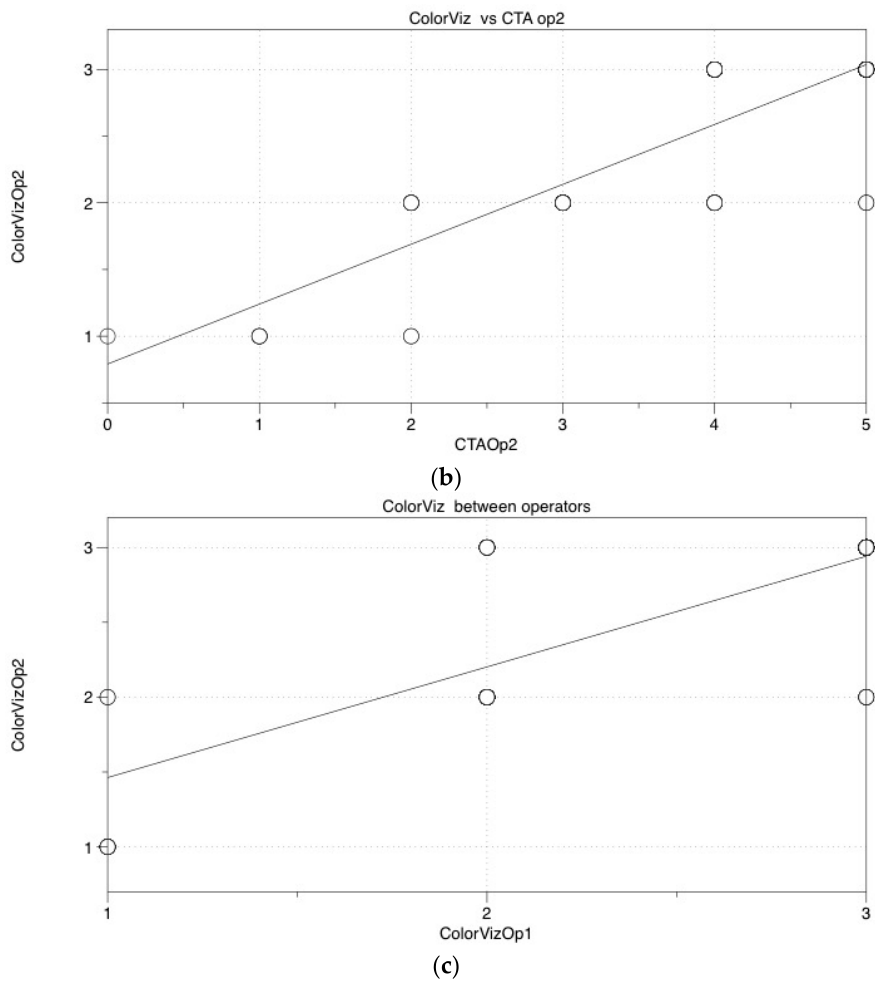
Figure 4. Statistical Graphs. ( a , b ), Graphs showing good accordance for both operators when comparing ColorViz to mCTA ( r = 0.735, p < 0.001 and r = 0.839, p < 0.001, respectively); ( c ) Graph showing good accordance between operators when comparing ColorViz scores ( r = 0.890, p < 0.001).